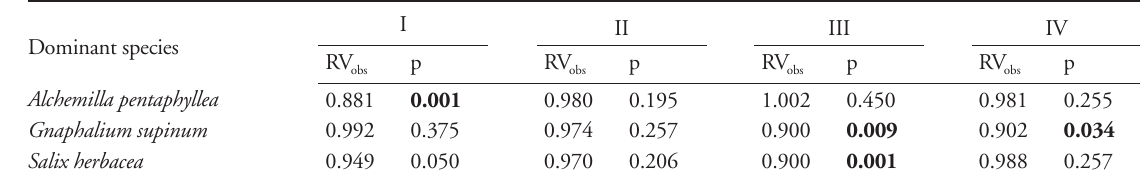
Table 6. Spatial relationships of dominant snowbed species with the remaining vegetation for each snowmelt date. Aggregations and segregations were detected by calculating the observed variance ratio (RV ) and comparison to the null model with randomly distrib- obs uted species. A value of RV = 1 means a random distribution of species, values of RV < 1 suggest segregation, RV > 1 indicate obs obs obs aggregation. Significant p-values at < 0.05 in bold. Snowmelt dates: I = 2 Jun 2003, II = 9 Jun 2003, III = 16 Jun 2003, IV = 23 Jun 2003. n for each snowmelt date = 120